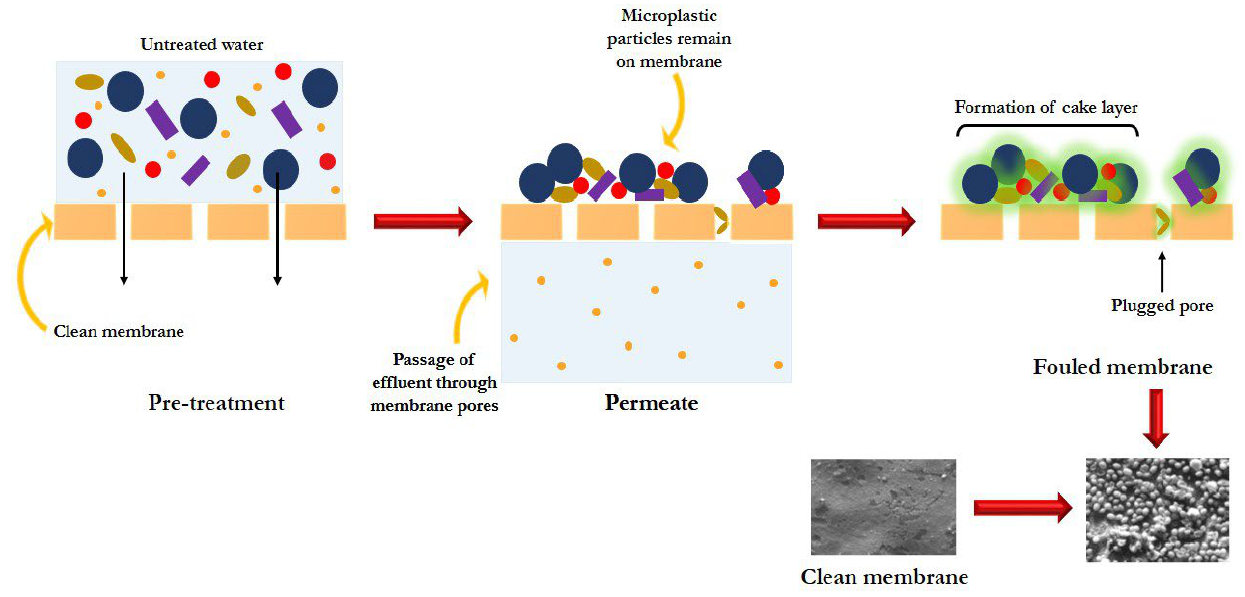
Figure 7. Schematic representation of microplastic removal by membrane filtration and membrane fouling [58].